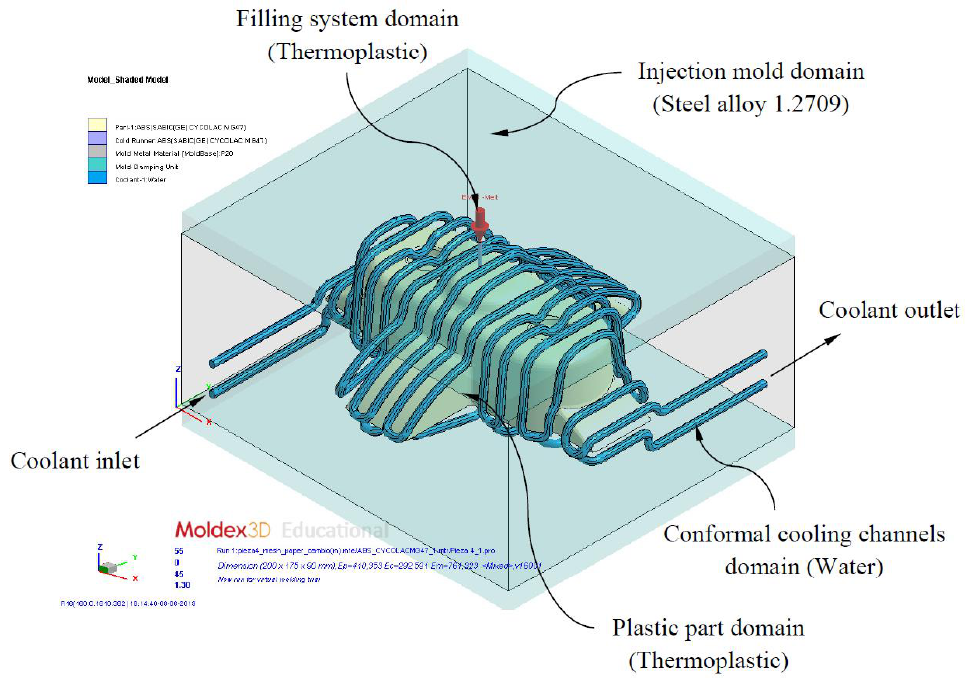
Figure 13. Definition domains and boundary conditions of thermal modeling. Table 7. Statistics of meshes defined for each plastic part analyzed